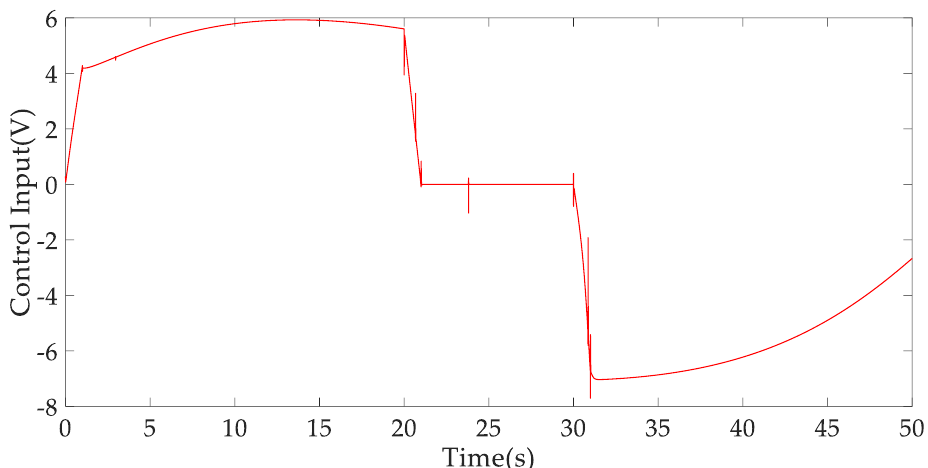
Figure 10. The control input in NRC.